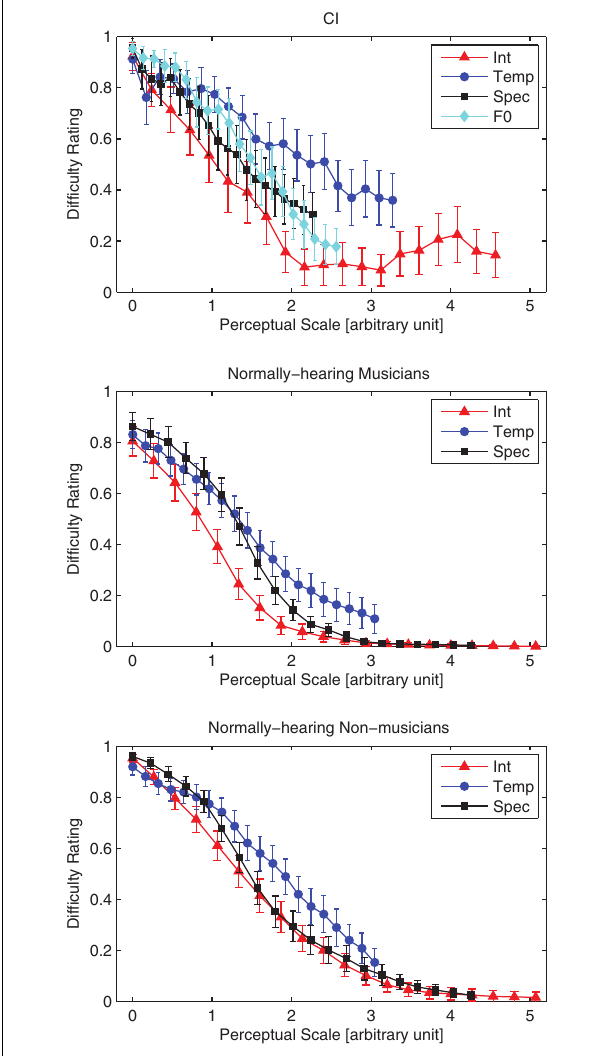
FIGURE 5 | Replots the difficulty ratings from Experiment 1, but with a different abscissa based on a perceptual scale determined from dissimilarity ratings (Experiment 2). The error bars show the standard error of the